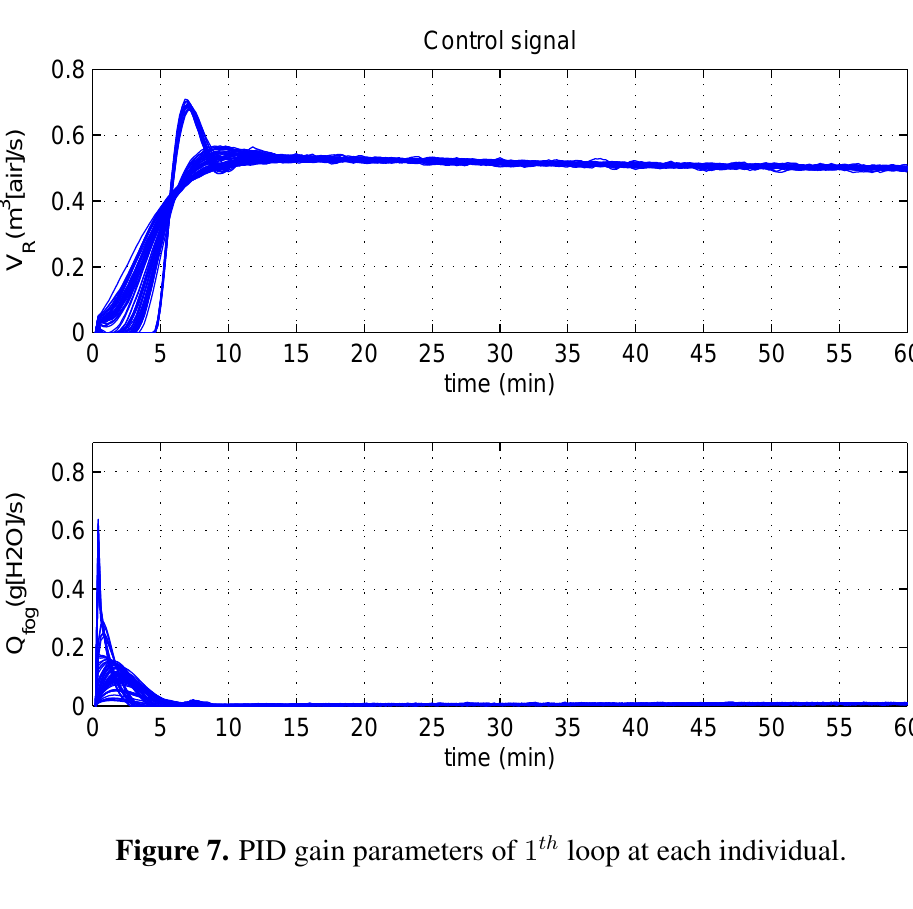
Figure 6. The corresponding control signals.